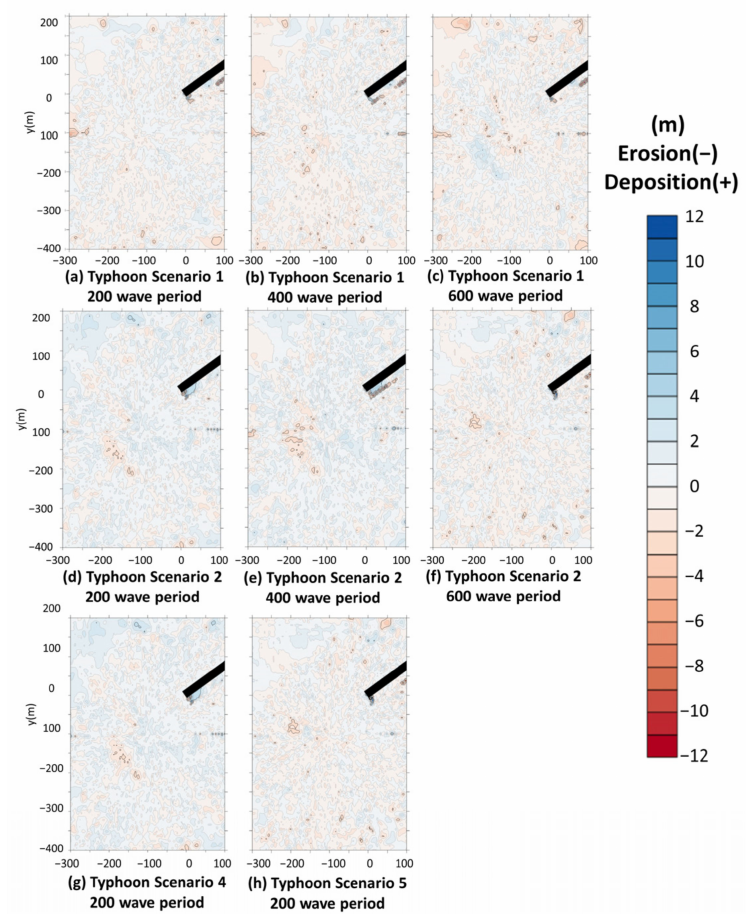
Figure 28. Topographic change under typhoon 1